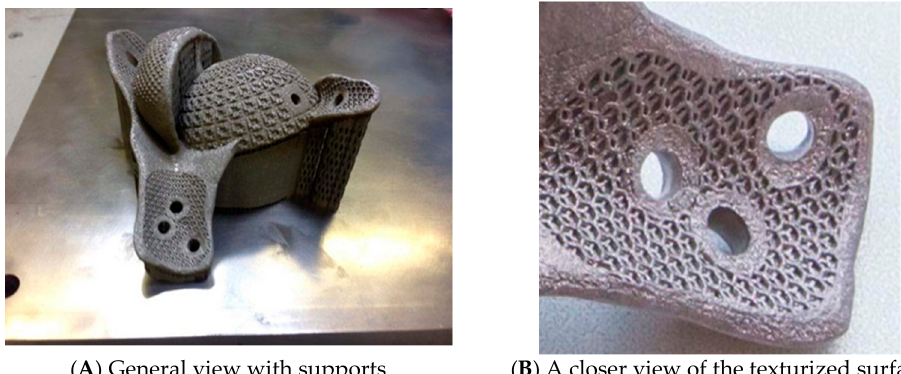
Figure 9. Titanium alloy hip implants produced by SLM [72].